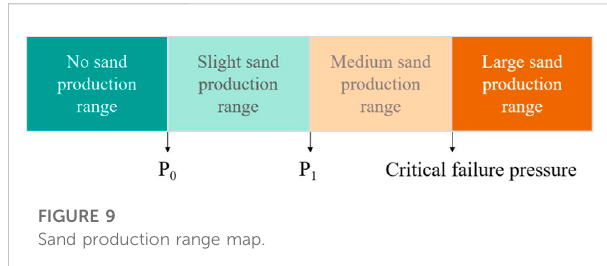
FIGURE 9 Sand production range map.